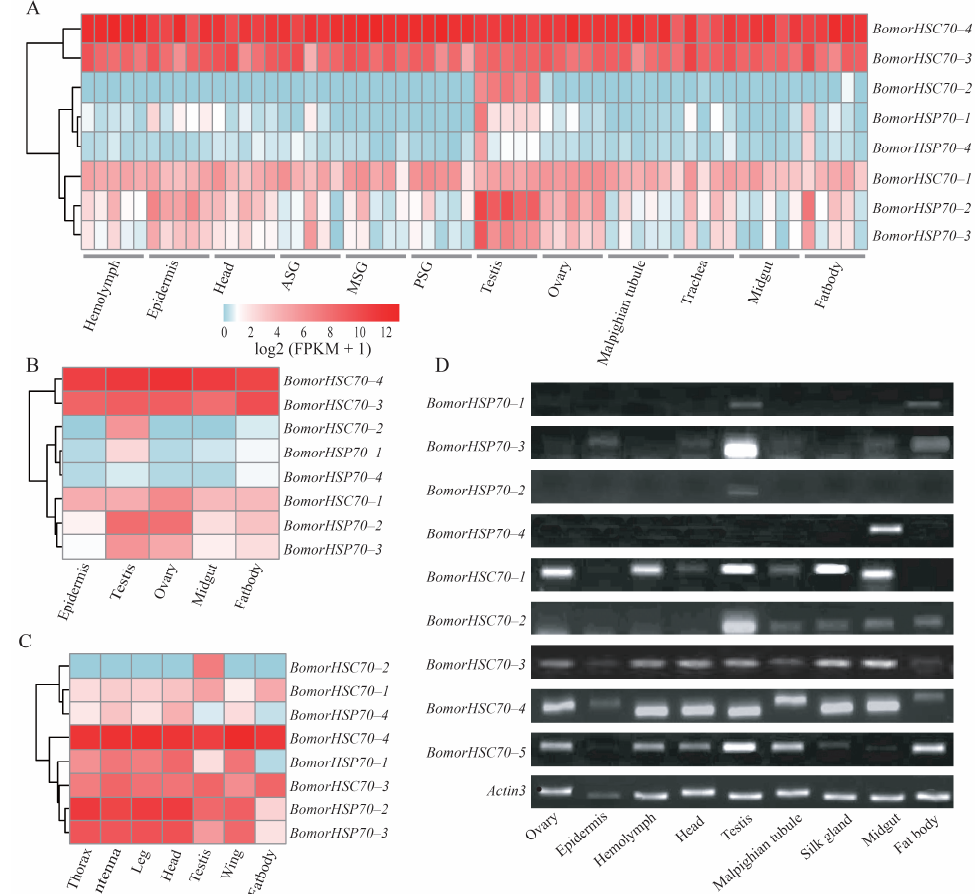
Figure 3. Spatio-temporal expression patterns of HSP70/HSC70 genes in the silkworm. ( A ) Expressions of HSP70/HSC70 genes in various tissues on day 3 of the fifth-instar larvae. ( B ) Transcriptional levels in various tissues of the pupae. ( C ) Tissue expression patterns in adults. Based on the transcriptome data, genome-wide analysis of developmental and tissue expression profiles was conducted in the silkworm and was deposited in SilkDB3.0 [43]. In this study, we downloaded the expression data (https://silkdb.bioinfotoolkits.net/base/download/ (accessed on 1 July 2021)) and extracted the corresponding expressions for the silkworm HSP70/HSC70 genes. Eight of them have expression data and were presented in ( A – C ). ( D ) Tissue expressions were detected by RT-PCR on day 3 of the fifth-instar larvae. The silkworm cytoplasmic actin A3 gene was used as an internal control and abbreviated as actin3 .